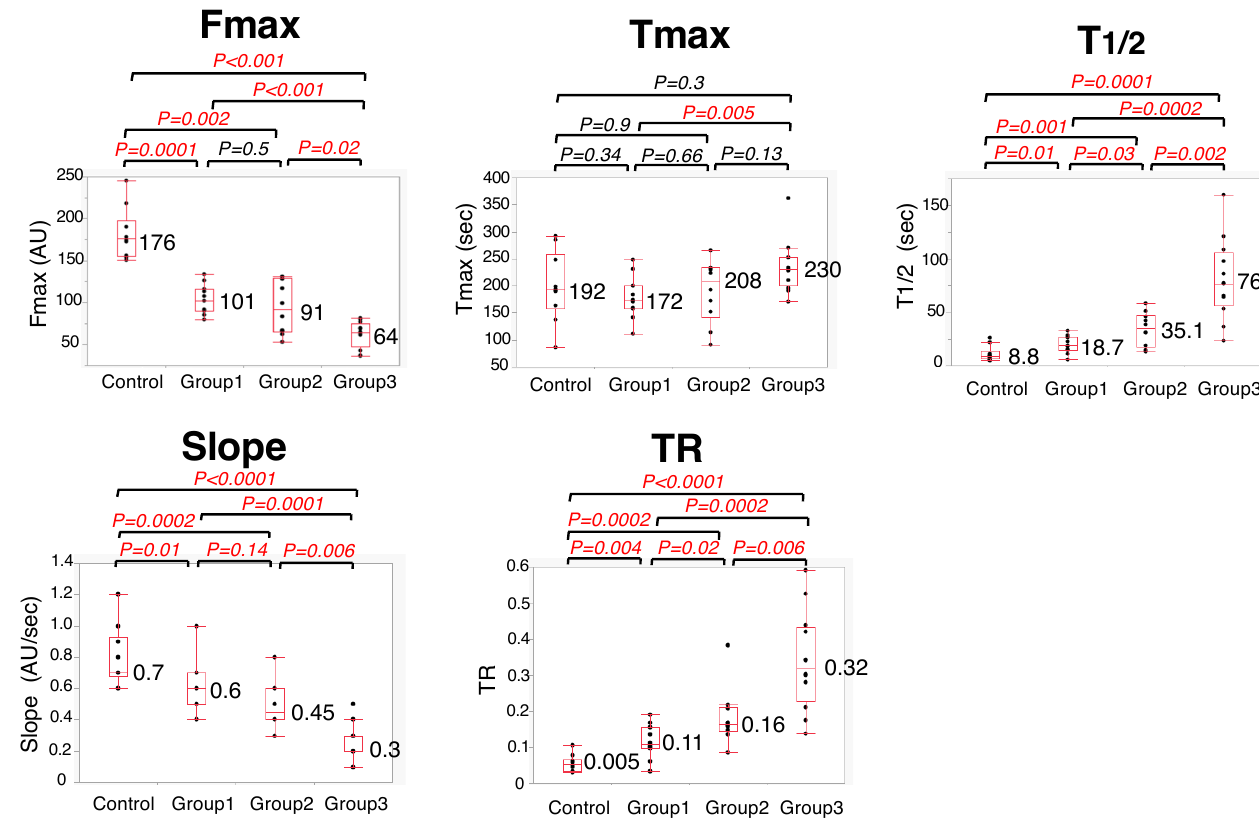
Figure 4. Comparison of five ICG fluorescence-related parameters between four